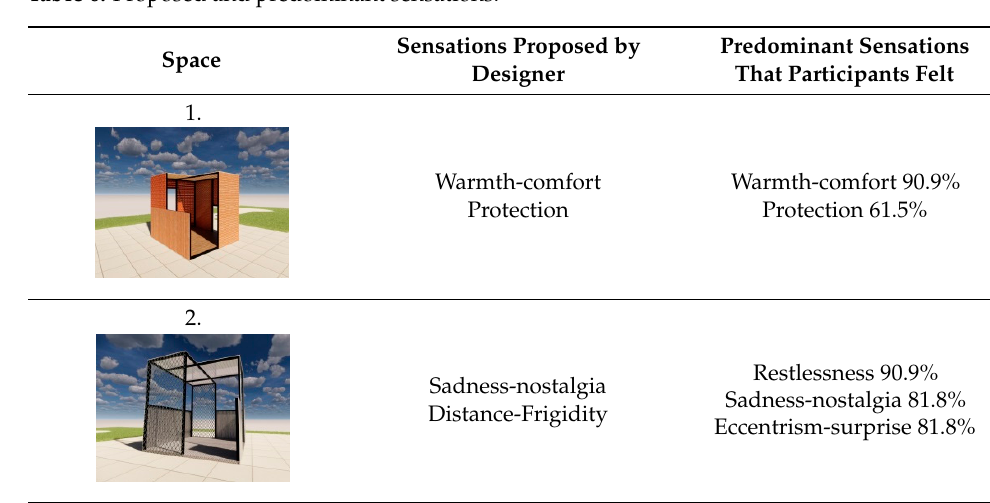
That Participants Felt